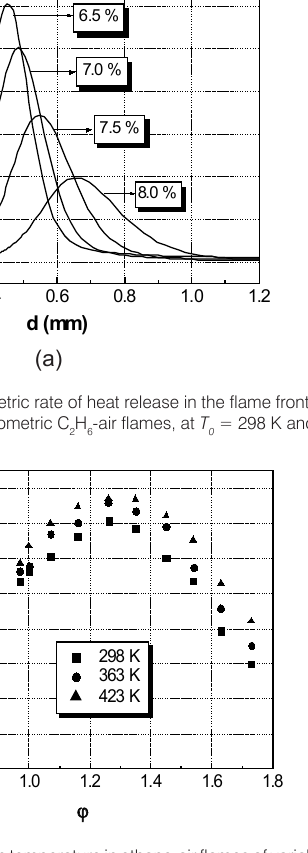
Figure 11. The ignition temperature in ethane-air flames of variable initial composition and temperature, at ambient initial pressure.